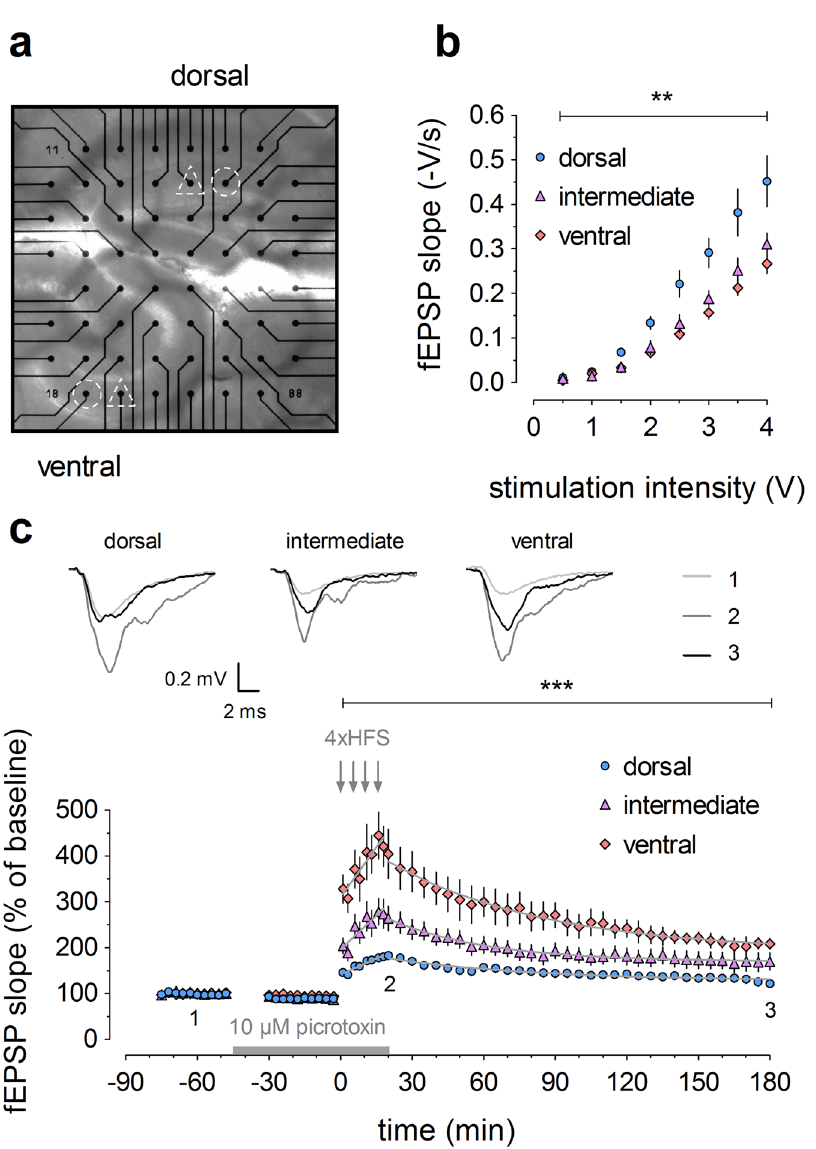
Figure 1. Young mice (2–3 months old) exhibit distinct electrophysiological properties in dorsal, intermediate and ventral dentate gyrus. ( a ) Image of a dorsal (top) and ventral (bottom) hippocampal slice positioned simultaneously on the multi-electrode array (MEA), zoomed in on the dentate gyrus. Selected stimulation electrodes (triangles) target the medial perforant path. Recording channels of interest (circles) are also indicated. ( b ) Input/output relationships of dorsal (n = 9), intermediate (n = 6) and ventral (n = 6) hippocampal slices indicate that basal synaptic transmission gradually decreases along the dorsoventral axis. ( c ) High- frequency stimulation (HFS; four trains of 1 s duration at 100 Hz) in dorsal (n = 9), intermediate (n = 8) and ventral (n = 6) slices induces LTP with a higher magnitude and distinct induction and decay kinetics in the ventral compared to intermediate and dorsal DG. Inset shows representative traces of field excitatory postsynaptic potential (fEPSP) for baseline, 20 min post-HFS and 180 min post-HFS, as indicated by numbers 1–3. 10 μ M picrotoxin was added to the ACSF after baseline and until the end of HFS, as indicated by the bar. The grey lines superimposed on the data points denote the best-fitted functions for the induction of potentiation and subsequent decay. See Supplementary Table S1 for all equation parameters. Two-way RM-ANOVA was used for statistical analysis ( ** indicates p < 0.01 and *** indicates p <